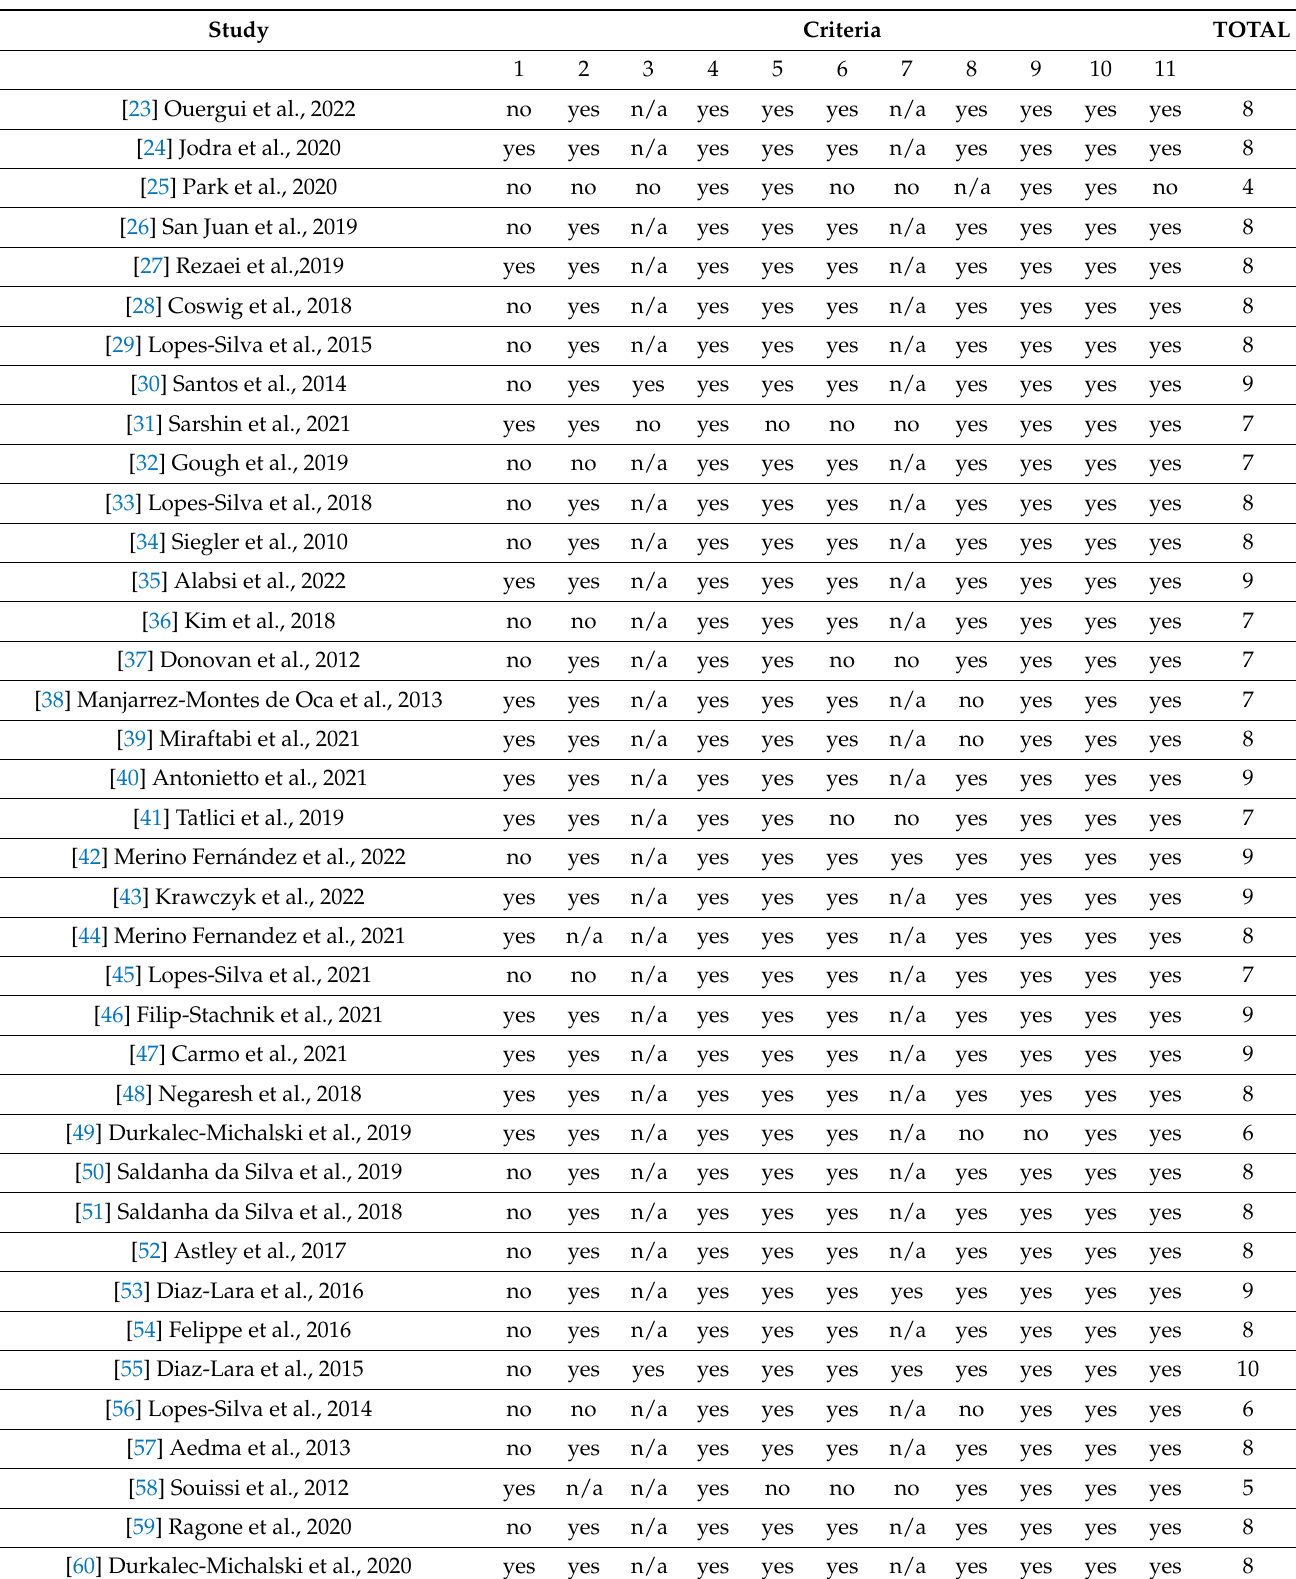
Table 3. PEDro scale scores by